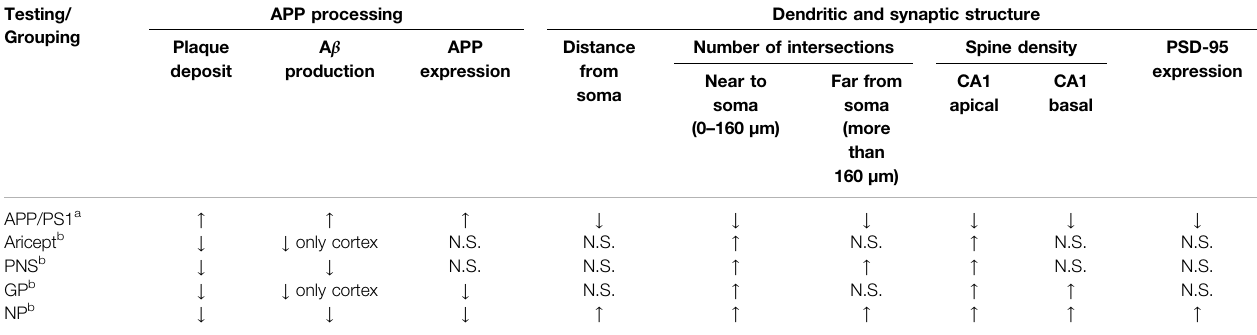
TABLE 1 | Effects on the APP processing and synaptic structure.